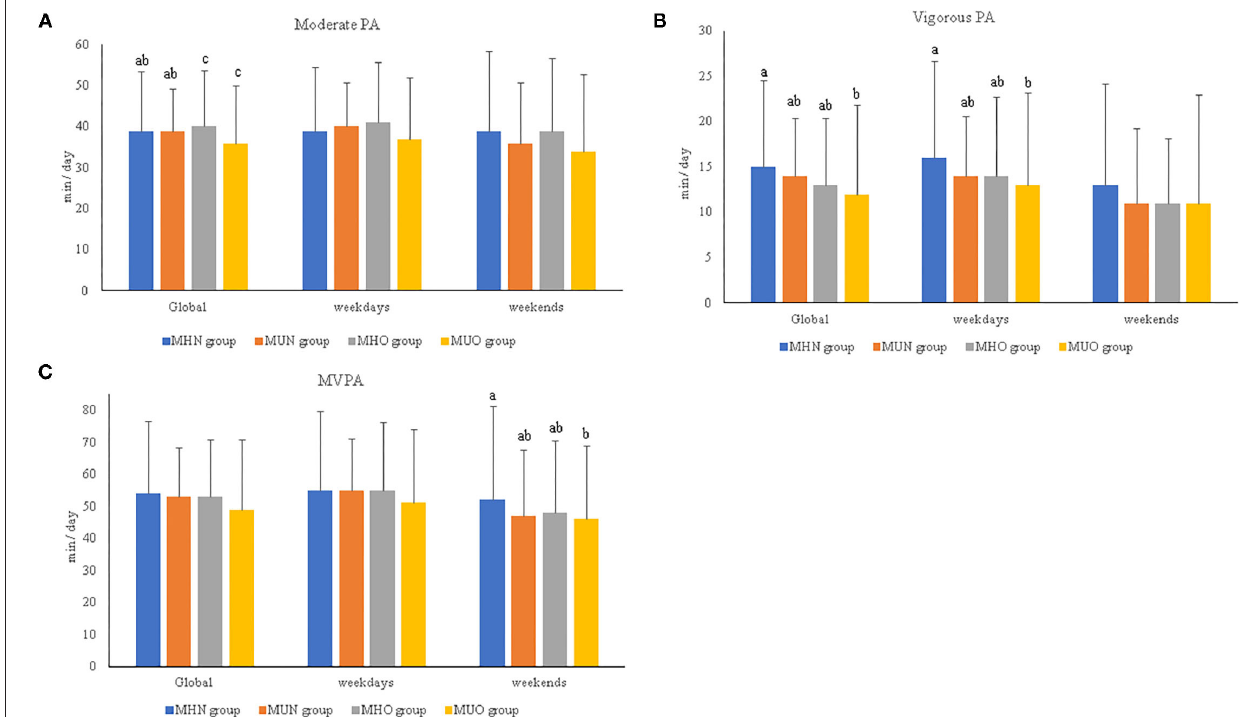
FIGURE 1 | (A–C) Relevant results of physical activity intensities and duration per day in prepubertal children according to metabolically healthy or unhealthy status and normal weight or overweight/obesity. MHN, metabolically healthy normal weight group; MUN, metabolic unhealthy normal weight group; MHO, metabolically healthy overweight/obesity group; MUO, metabolic unhealthy overweight/obesity group; PA, physical activity; MVPA, moderate-to-vigorous physical activity. The p- values were obtained two-way ANOVA or Kruskal–Wallis test. Non-matching superscript letters ( a , b , or c ) indicate significant differences ( p < 0.05) by pairwise post-hoc tests adjusted for age and sex to determine differences between experimental groups. The data are subdivided in global data, by weekend, or by weekdays.